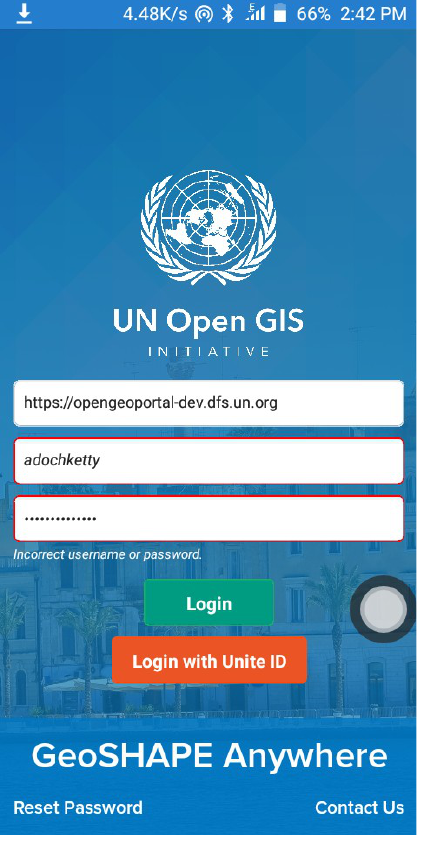
Figure 1. The login window of UN AnyWhere.